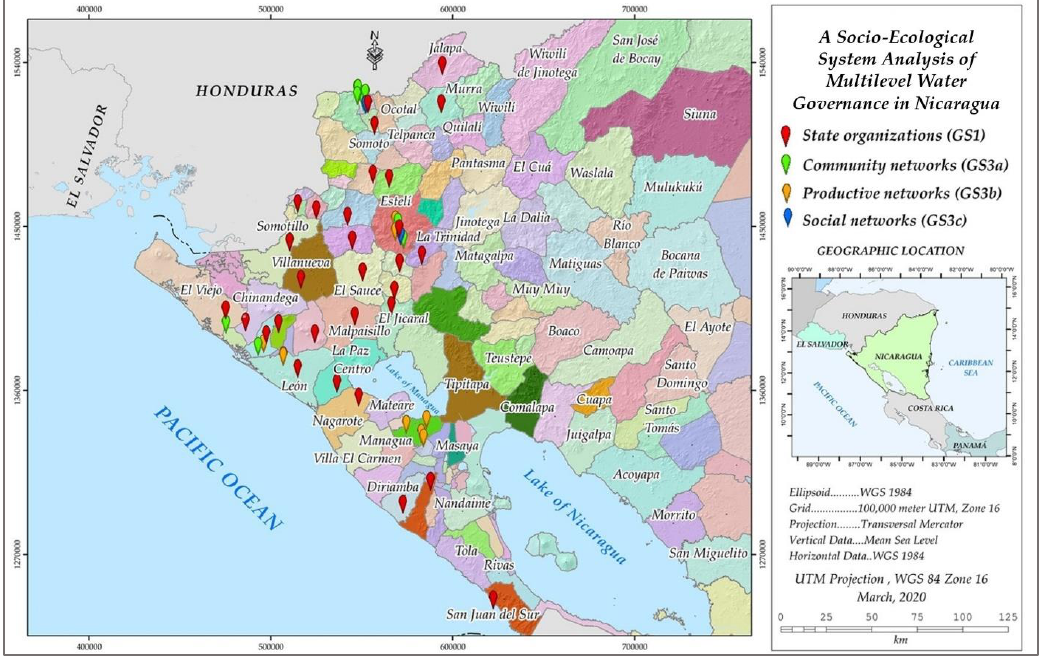
Figure 2. Distribution of actors interviewed.